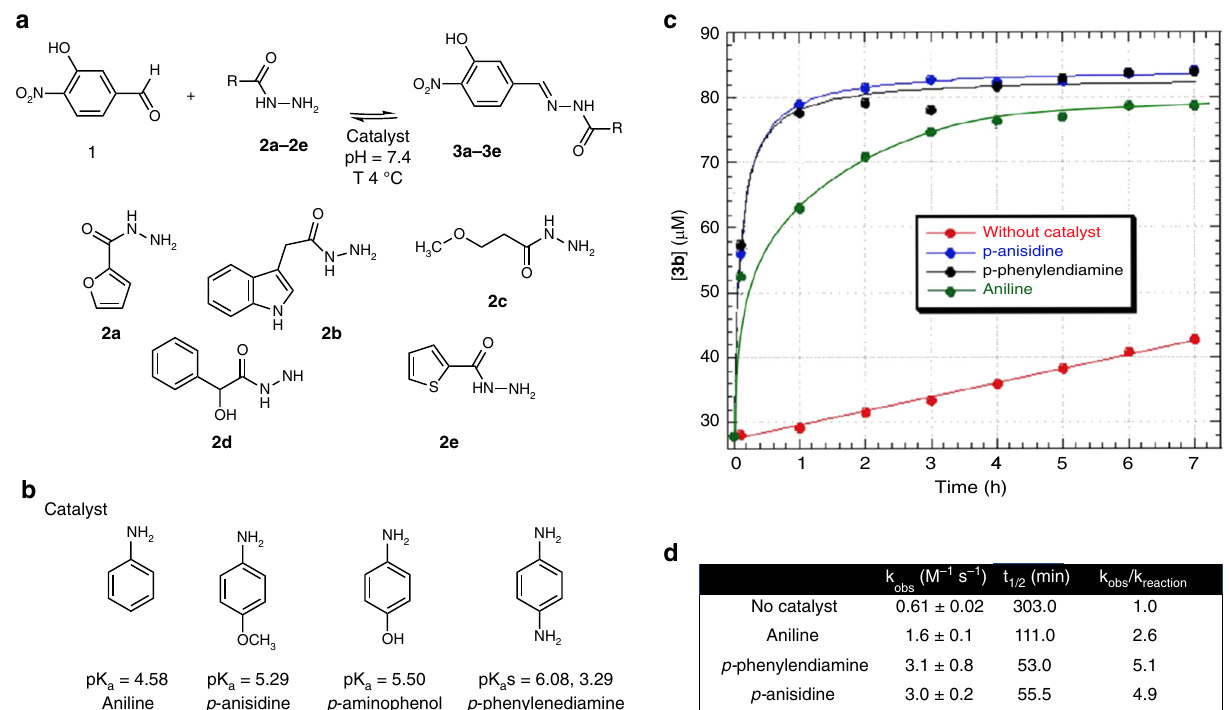
Fig. 2 Aniline derivatives tested as DCL hydrazone exchange catalysts 27 . a DCL building blocks and library conditions at physiological pH and low temperature, b Aniline derivatives used as catalysts. c Time course formation of compound 3b using an aldehyde concentration of 0.09 μ M in 20 mM Tris buffer (pH 7.4), acylhydrazide 2b (0.27 μ M), T = 4 °C, 5% DMSO in the absence of the catalyst (red dots), and in the presence of 15 mM of aniline (green dots), p -anisidine (blue dots) and p -phenylendiamine (black dots). d Kinetic parameters ( K obs and t 1/2 ) of acylhydrazone 3b formation calculated for a pseudo-second-order rate equation in the absence or in the presence of different catalysts (Supplementary Fig. 1 and Supplementary Methods). Mean ± SD from three independent experiments. The right column shows the rate enhancement of catalysts relative to the uncatalyzed samples. p -aminophenol was discarded as it got quickly transformed into the quinone derivative. Source data are provided as a Source Data fi